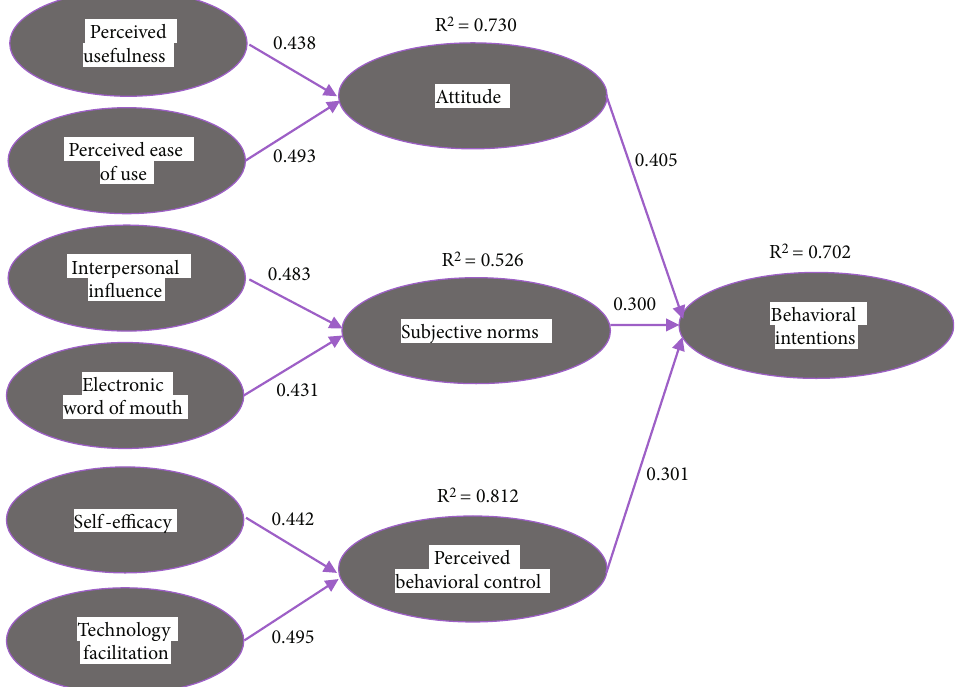
Figure 1: Path coe ffi cient diagram of the NTC app